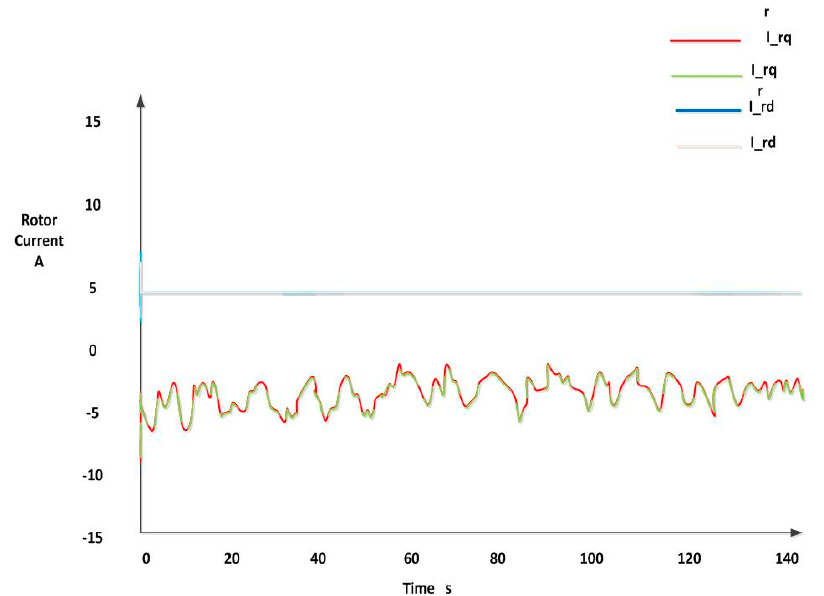
Energies 2018 , 11 , x Figure 11. The DFIG rotor quadrature and direct current curves ( I rq and I rd ) . Figure 11. The DFIG rotor quadrature and direct current curves ( 𝐼 (cid:3045)(cid:3044) and 𝐼 (cid:3045)(cid:3031) ) .